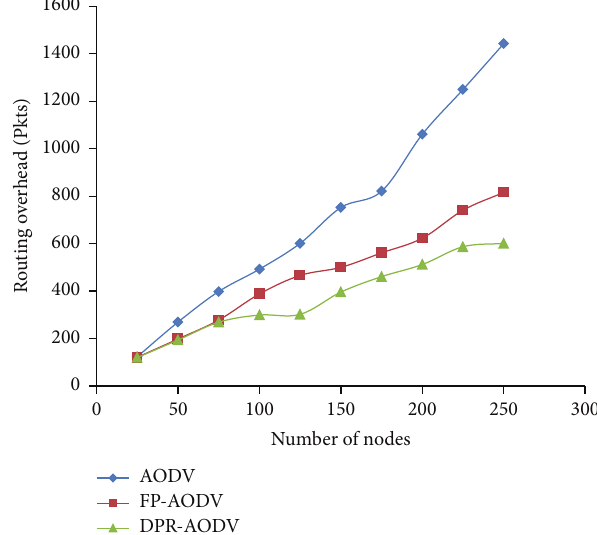
Figure 2: Overhead on routing versus number of mobile nodes.